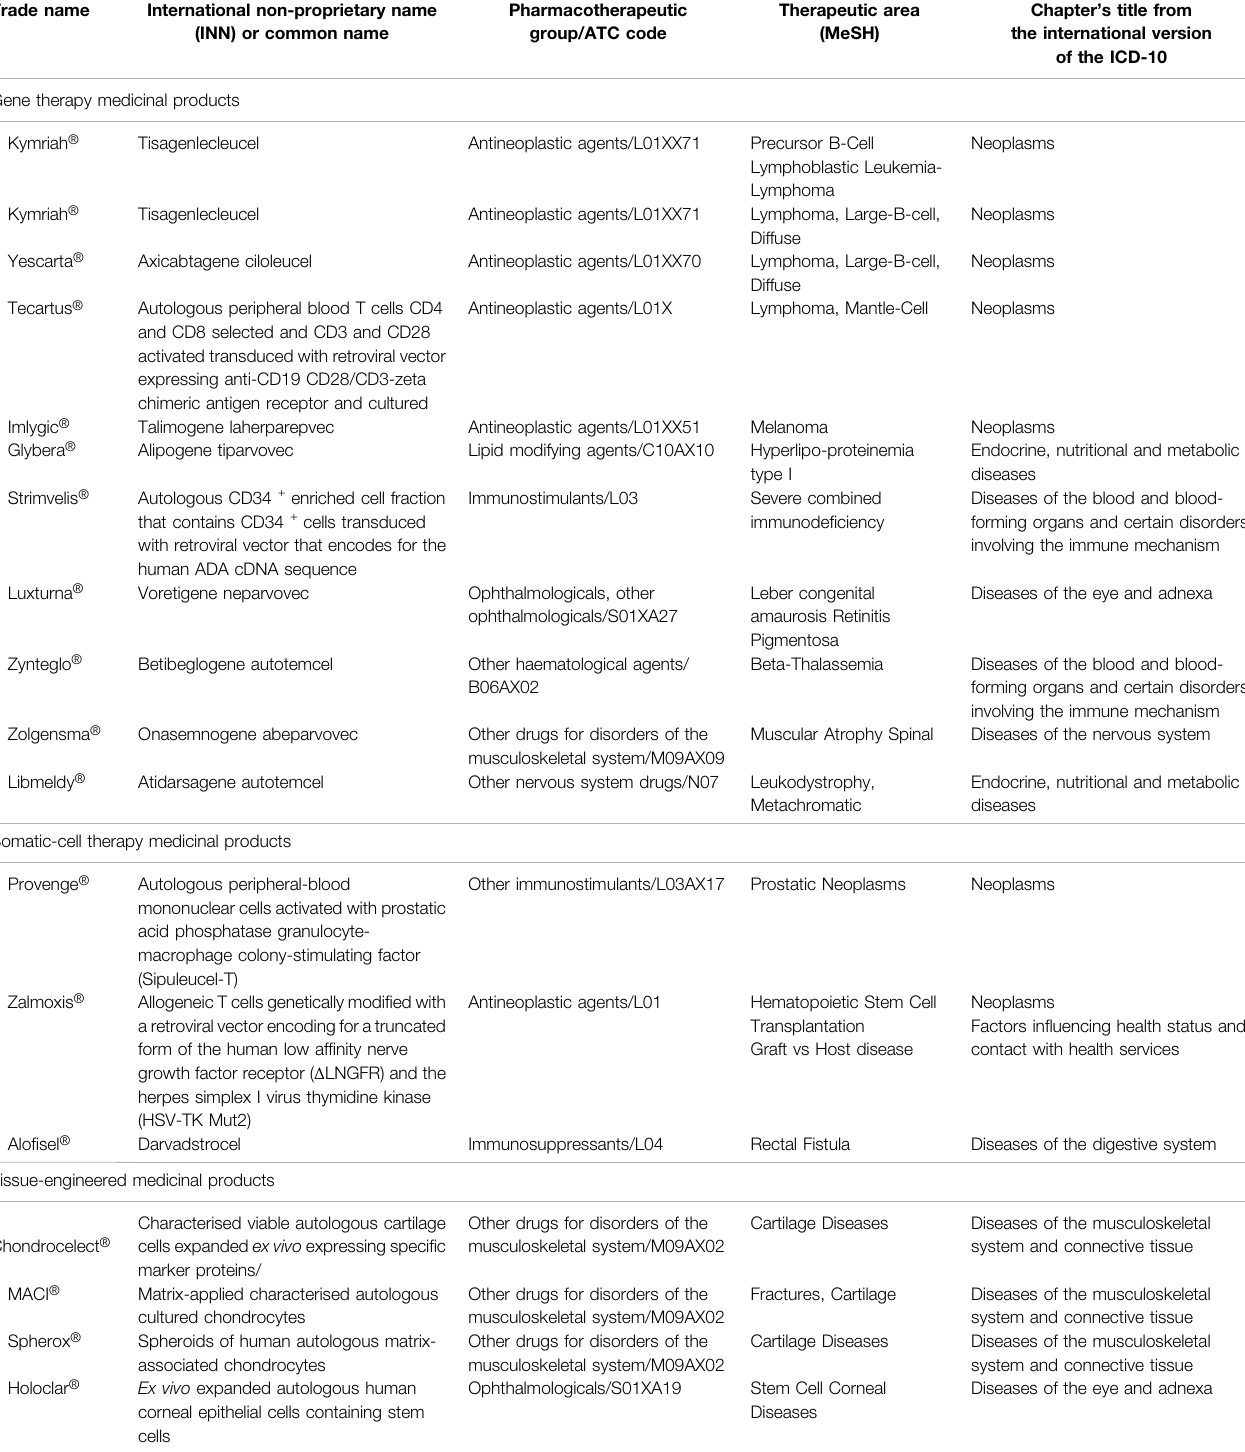
TABLE 1 | Approved ATMPs in the European Union and therapeutic